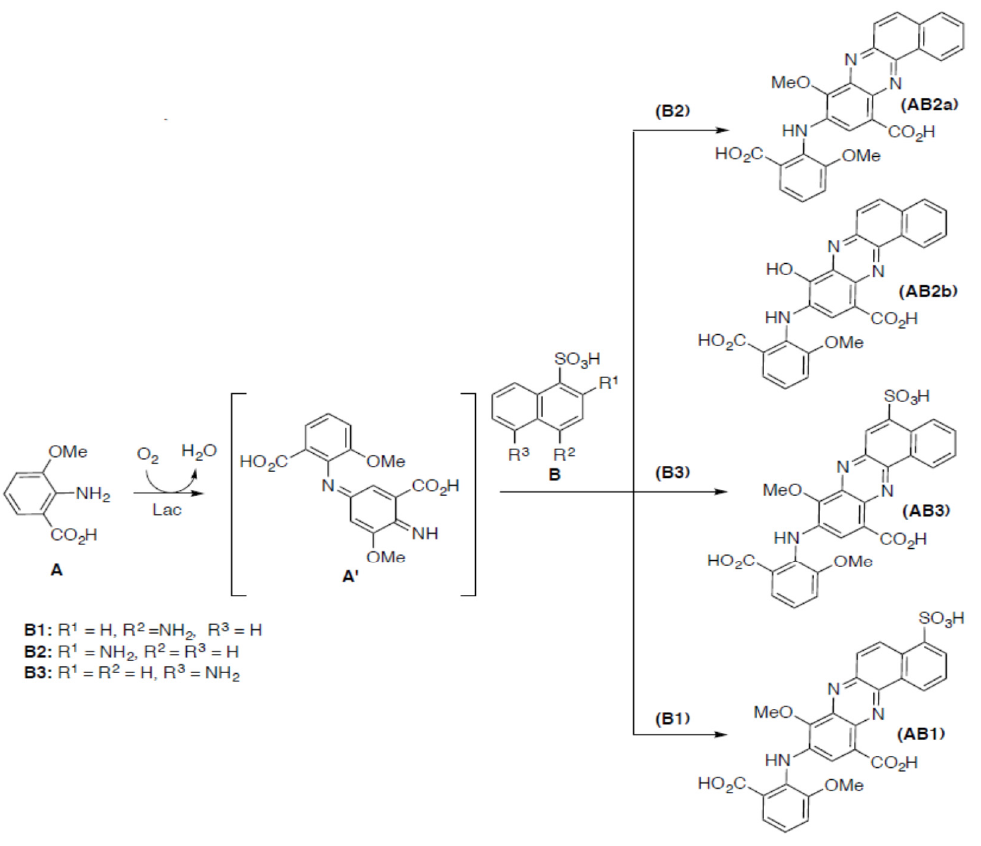
Figure 6. Proposed pathway of synthesis of phenazines (AB1, AB2a, AB2b, and AB3) as a result of LAC-mediated heteromolecular coupling reactions of aminomethoxycarboxylic acid (A) with three different isomers of aminonaphthalene (B1, B2, and B3). Acronyms of substrates and products have been bolded.